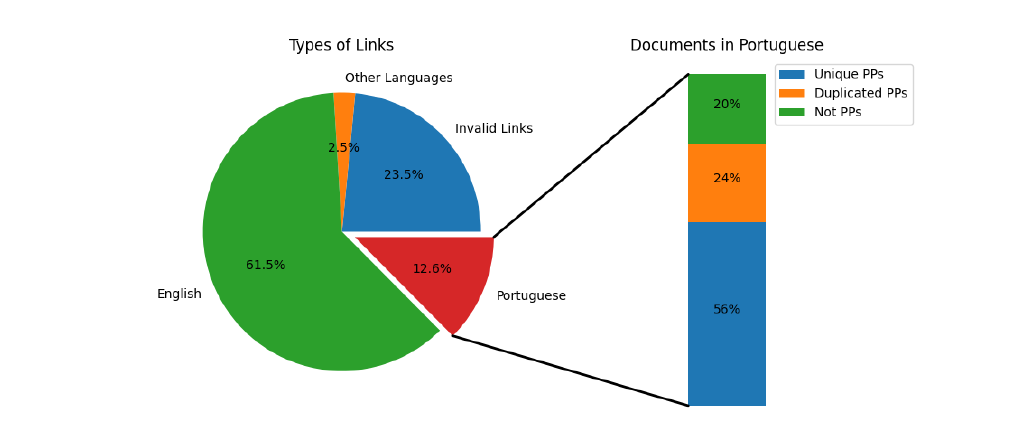
Figure 2. Fraction of links and files according to their types.